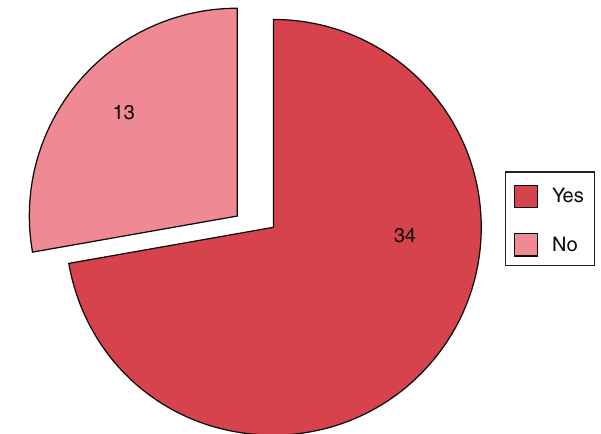
Perform procedures with newborns at ‘‘high risk’’ for hearing loss ( n = 47).